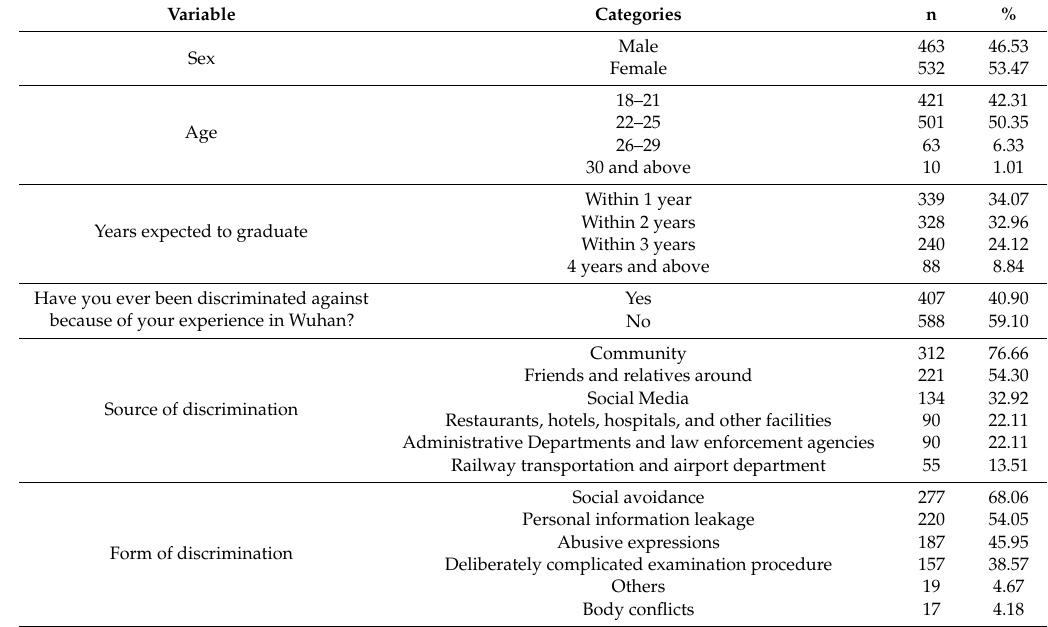
Table 1. Demographic characteristics and discrimination relative information.